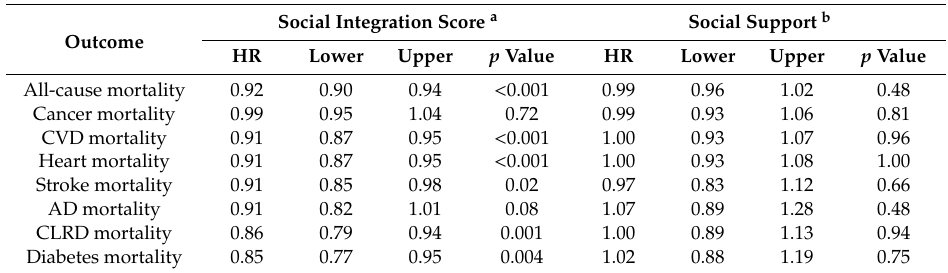
Table 3. Hazard ratios for all-cause, cardiovascular, and cause-specific mortality by received social integration score and social support.